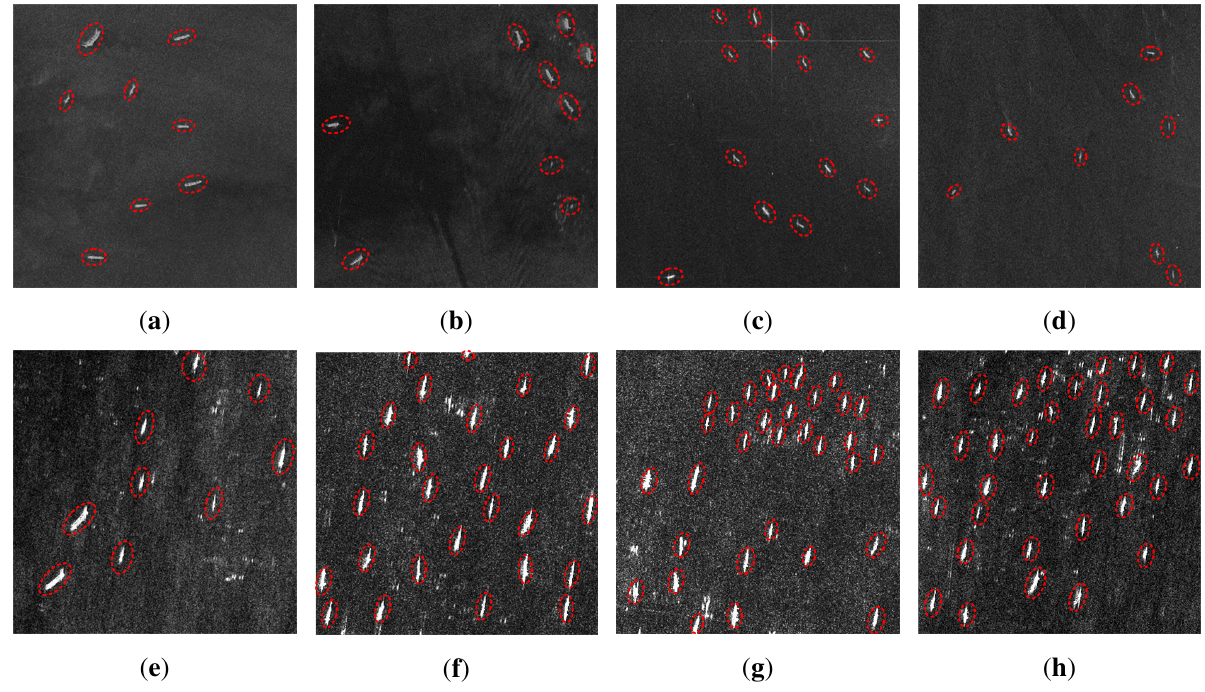
Figure 3. SAR amplitude images with marked ships. ( a , b ) The TerraSAR-X data, with 8 and 9 ships, respectively. ( c , d ) RADARSAT-2 data, the numbers of ships are 14 and 8, respectively. ( e – h ) TerraSAR-X data, with 9, 28, 33 and 36 ships,